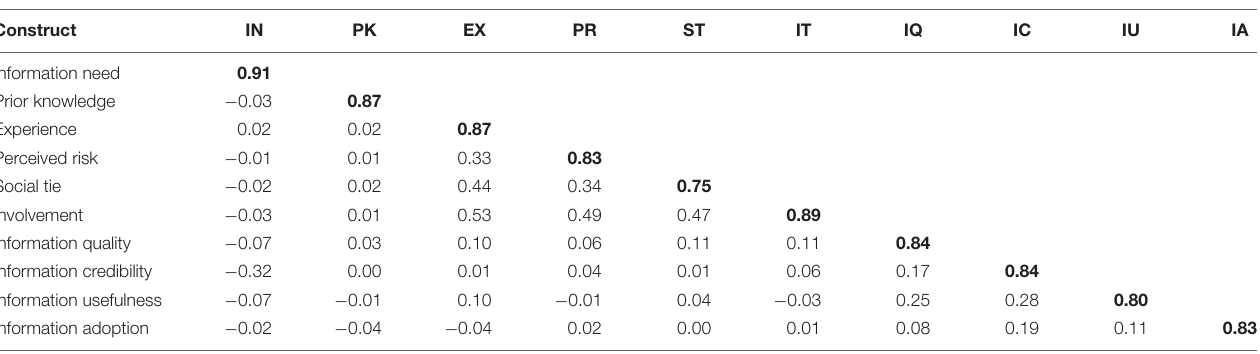
TABLE 3 | | The discriminant validity ( n =